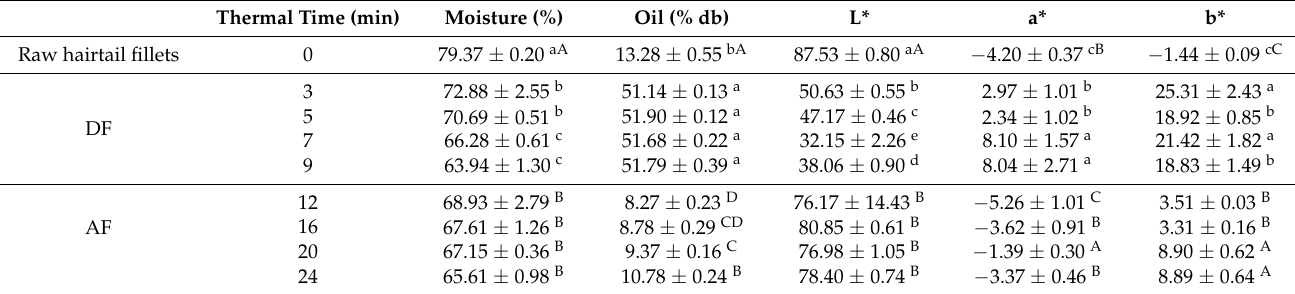
Table 1. Moisture, oil contents and colour of fried hairtail